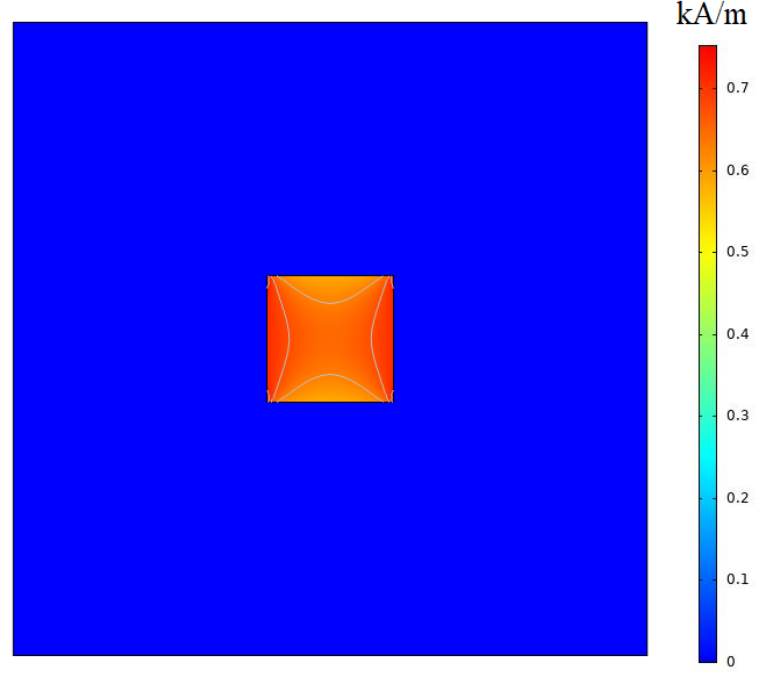
Figure 4. Magnetization